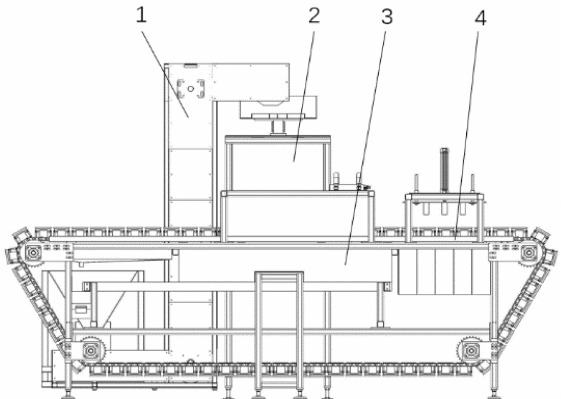
Figure 1. Diagram of overall structure of automatic filling device for lotus root with glutinous rice.